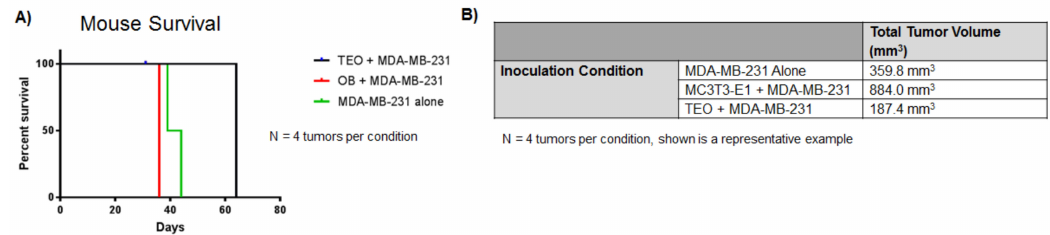
Figure 5. Mice inoculated with a mix of TEO cells plus MDA-MB-231 breast cancer cells lived longer and had smaller tumors than mice inoculated with a mix of untreated MC3T3-E1 cells plus MDA-MB-231 breast cancer cells, or breast cancer cells inoculated alone. Athymic nude mice were inoculated with either mixes of (1) TEO cells plus MDA-MB-231GFP breast cancer cells; (2) MC3T3-E1 osteoblasts plus MDA-MB-231GFP breast cancer cells; or (3) MDA-MB-231GFP breast cancer cells alone. ( A ) Kaplain-Meier Survival curve of percent mouse survival over time. Blue line, TEO plus MDA-MB-231GFP; red line, MC3T3-E1 plus MDA-MB-231GFP; green line, MDA-MB-231 cells alone. ( B ) Tumor size (mm 3 ). At least four mice were used per condition per time point. Shown are representative